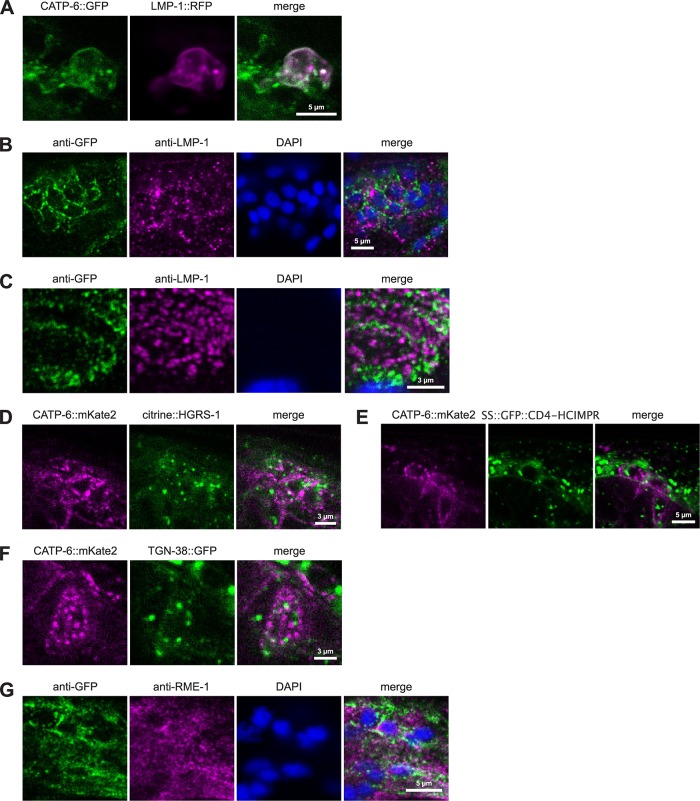
Subcellular localization of CATP-6 in neurons and pharynx.(A) Co-localization of native CATP-6::GFP vs. LMP-1::RFP in living neurons. catp-6(dx183[catp-6::gfp::3xFlag + loxP]) IV, Ex [Pcatp-6catp-6::gfp;Psth-1lmp-1::rfp;rol-6(d)]. (B-C) Immunostaining of native CATP-6::GFP vs. native LMP-1 in neurons and pharyngeal bulb. catp-6(dx183[catp-6::gfp::3xFlag + loxP]) IV. (D-F) Co-localization of native CATP-6::mKate2 vs. citrine::HGRS1, SS::GFP::CD4-HCIMPR, and TGN-38::GFP in living neurons. catp-6(dx179[catp-6::degron::mKate2::3xFlag + loxP]) IV, pwIS1039[psnx-1citrine::hgrs-1unc-54
UTR-cb-unc-119], pwIs1176[psnx-1ss-gfp-cd4-hcimpr
unc-54
UTR-cb-unc-119]; unc-119(ed3) and pwIs1175[psnx-1tgn-38::gfpunc-54
UTR-cb-unc-119]; unc-119(ed3). (G) Immunostaining of native CATP-6::GFP vs. native RME-1 in neurons. catp-6(dx183[catp-6::gfp::3xFlag + loxP]) IV.